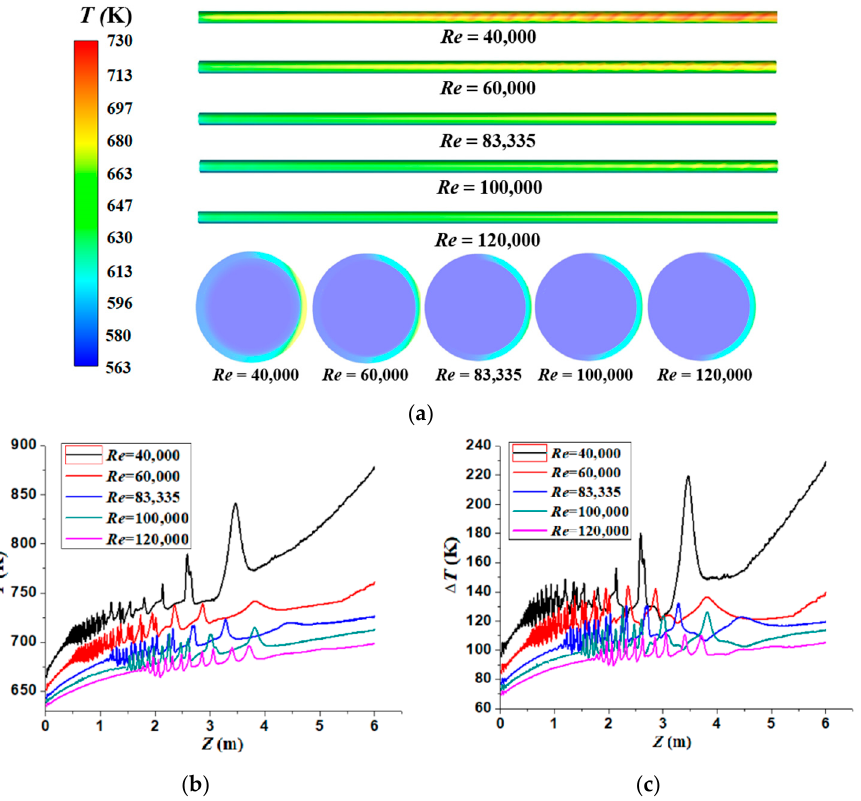
Figure 11. Temperature distributions for different Re values and α = 90°: ( a ) temperature contours on S1 and S2; ( b ) temperature distributions on Line 1; ( c ) temperature differences along the tube.